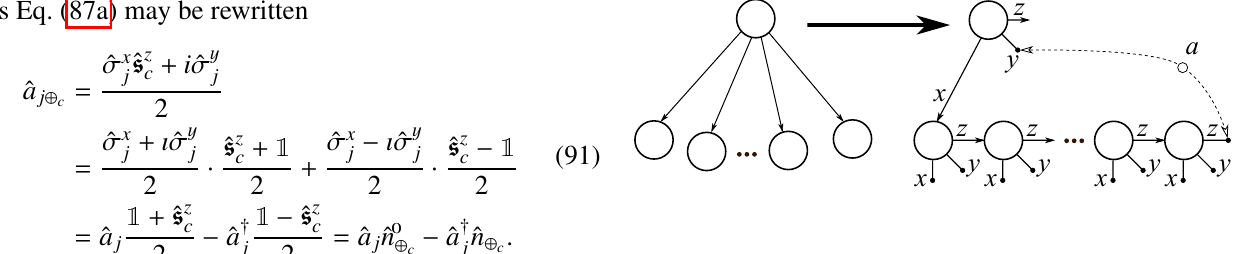
Figure 8: Multiple children encoding. Eq. (62) for binary x-y trees with Eq. (92) and Eq. (94) for nodes with arbitrary number of children obtained from binary x-z trees using the correspondence depicted in Fig.